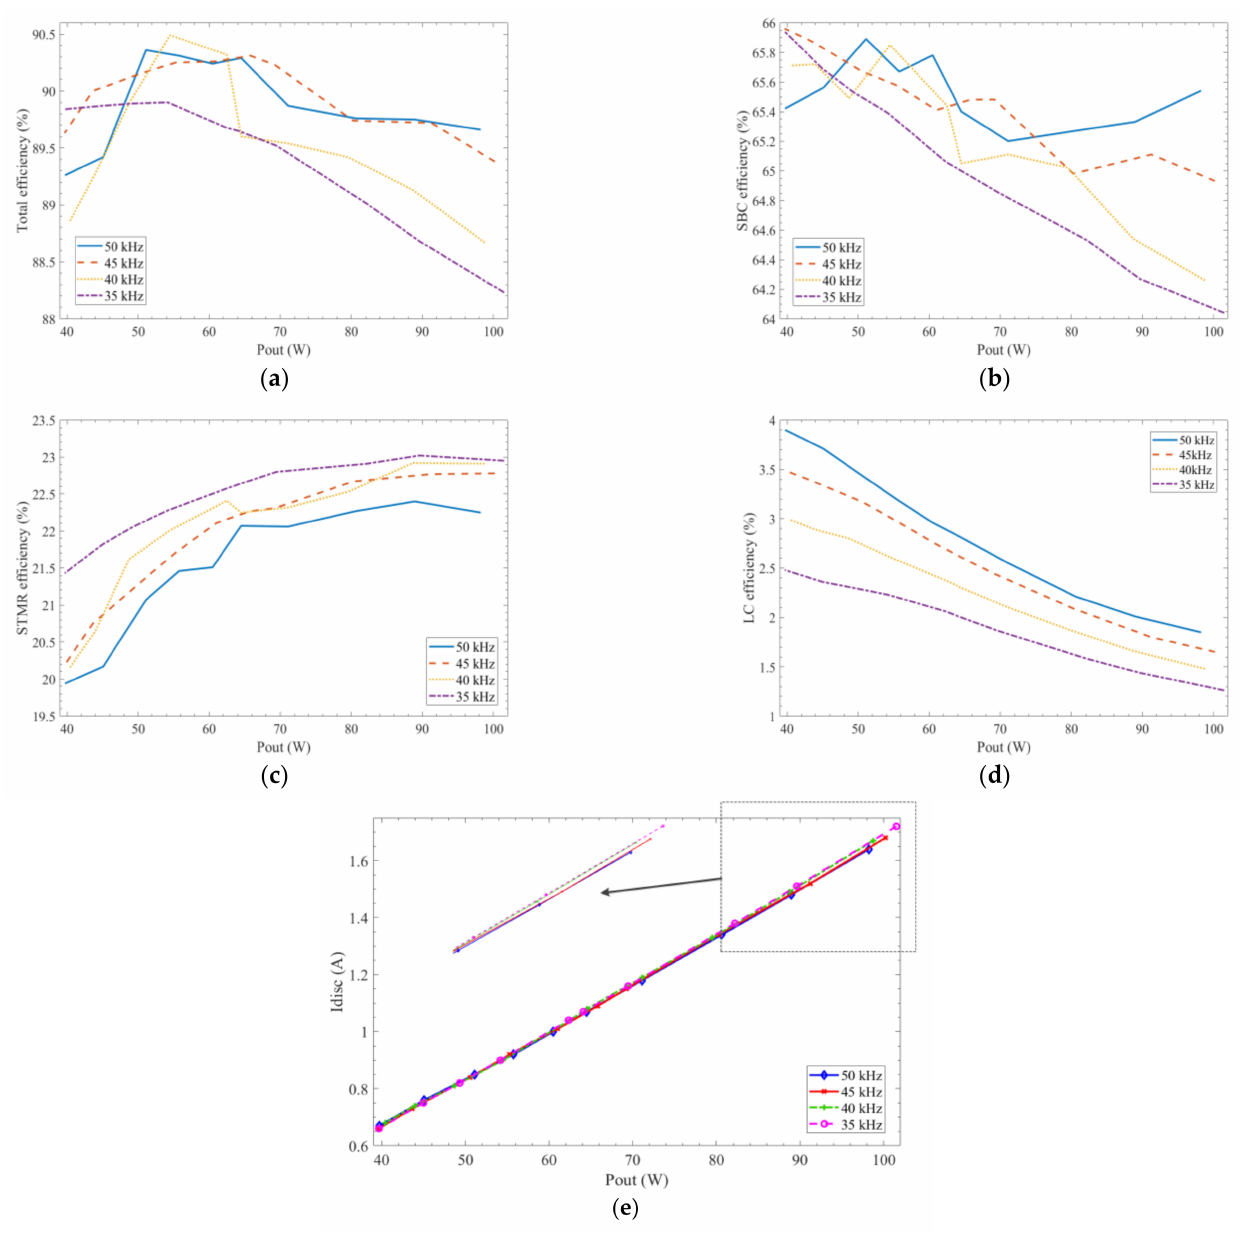
Figure 9. All parts of P2PG&AP mode efficiency and the average discharge current of donor pack at different f sw with the donor pack initial voltage of 66.8 V. ( a ) The total efficiency η P 2 PG & AP . ( b ) The SBC part of efficiency η SBC . ( c ) The STMR part of efficiency η STMR . ( d ) The LC quasi-resonator part of efficiency η LC . ( e ) The average discharge current of donor